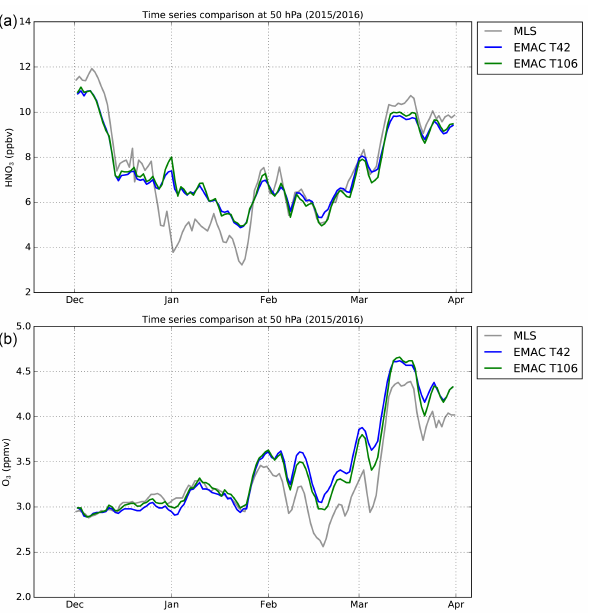
Figure 14. Time series of HNO 3 (a) and O 3 (b) from Aura/MLS measurements (grey) and from the EMAC T42L90 (blue) and EMAC T106L90 (green) at ∼ 50hPa averaged over 70–90 ◦ N (EMAC SORBIT output